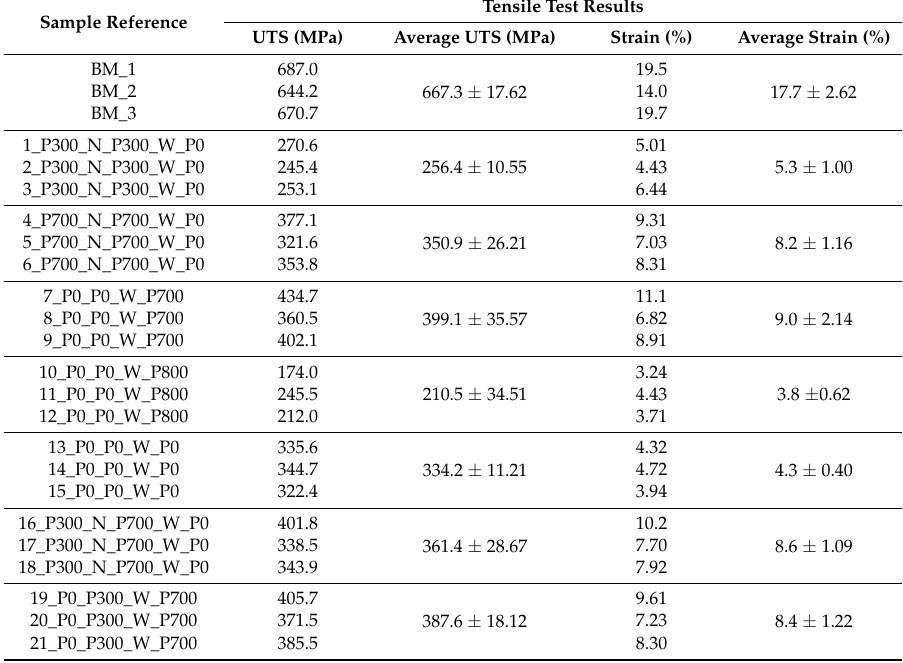
Table 4. Tensile test results for created